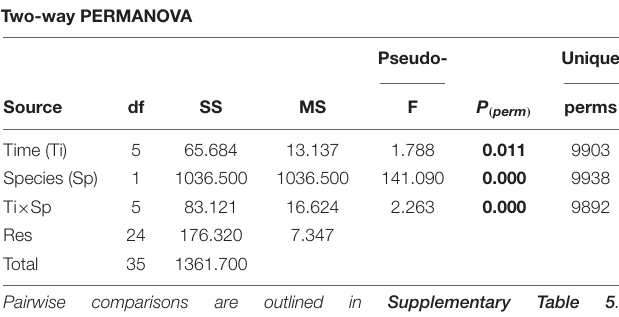
P ( perm ) < 0.05 are in bold.